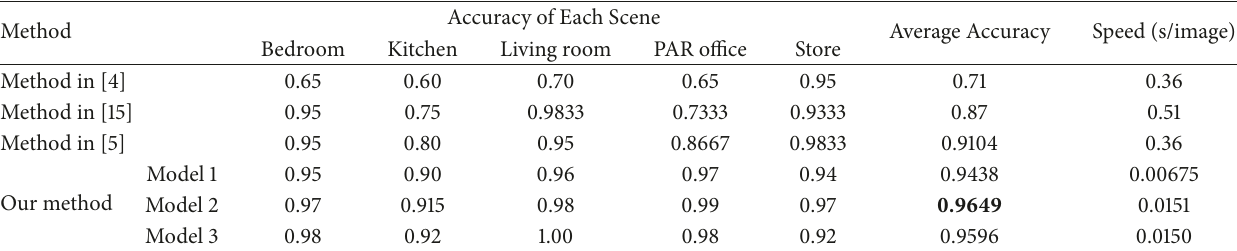
Table 6: Comparison between the proposed method and correlative methods on Scene 15 dataset.